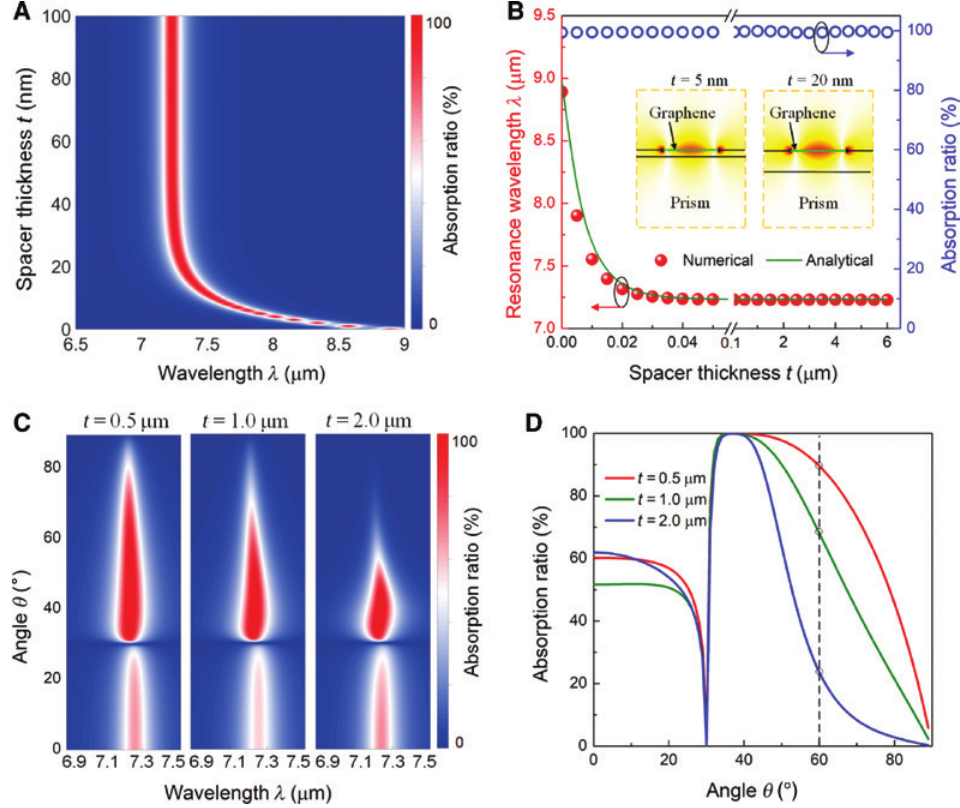
Figure 3: Effect of spacer thickness on the plasmonic absorption. (A) Absorption mapping as a function of the spacer thickness and incident wavelength. (B) Extracted resonant wavelength and absorption with varying spacer thicknesses. The green line is the analytically calculated results from Eq. (2). The inset shows the mode pattern of graphene plasmons. (C) Absorption mapping as a function of the incident angle and wavelength when t = 0.5, 1, and 2 μ m. (D) Extracted resonant absorption with varying incident angles when t = 0.5, 1, and 2 μ m. The refractive index of the prism is n